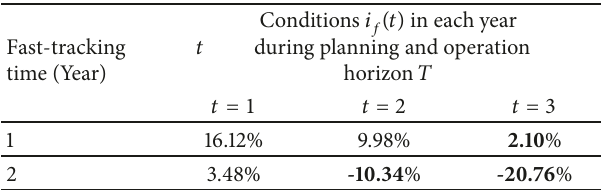
Table 8: Conditions for fast-tracking the rail transit line project in Scenario